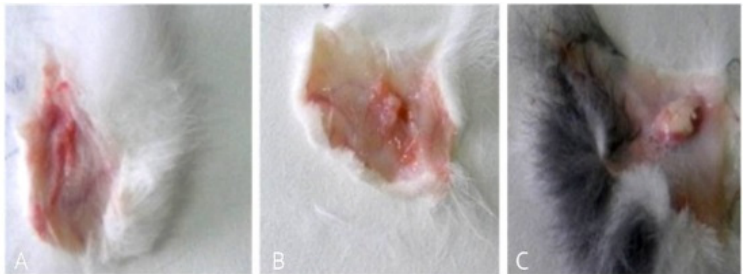
Figure 3. Samples selected for sampling: ( A – C ) lax subcutaneous tissue after implantation of three biomaterials.